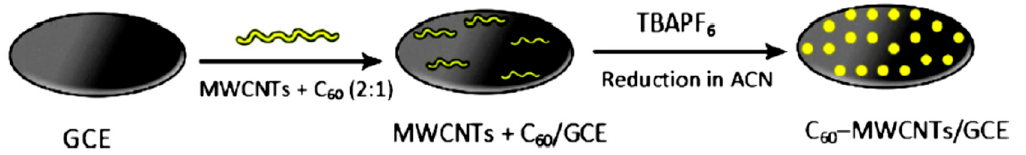
Figure 7. Scheme of fabrication of the C 60 –MWCNTs/GCE sensor. (Reproduced with permission of Elsevier from [95]).